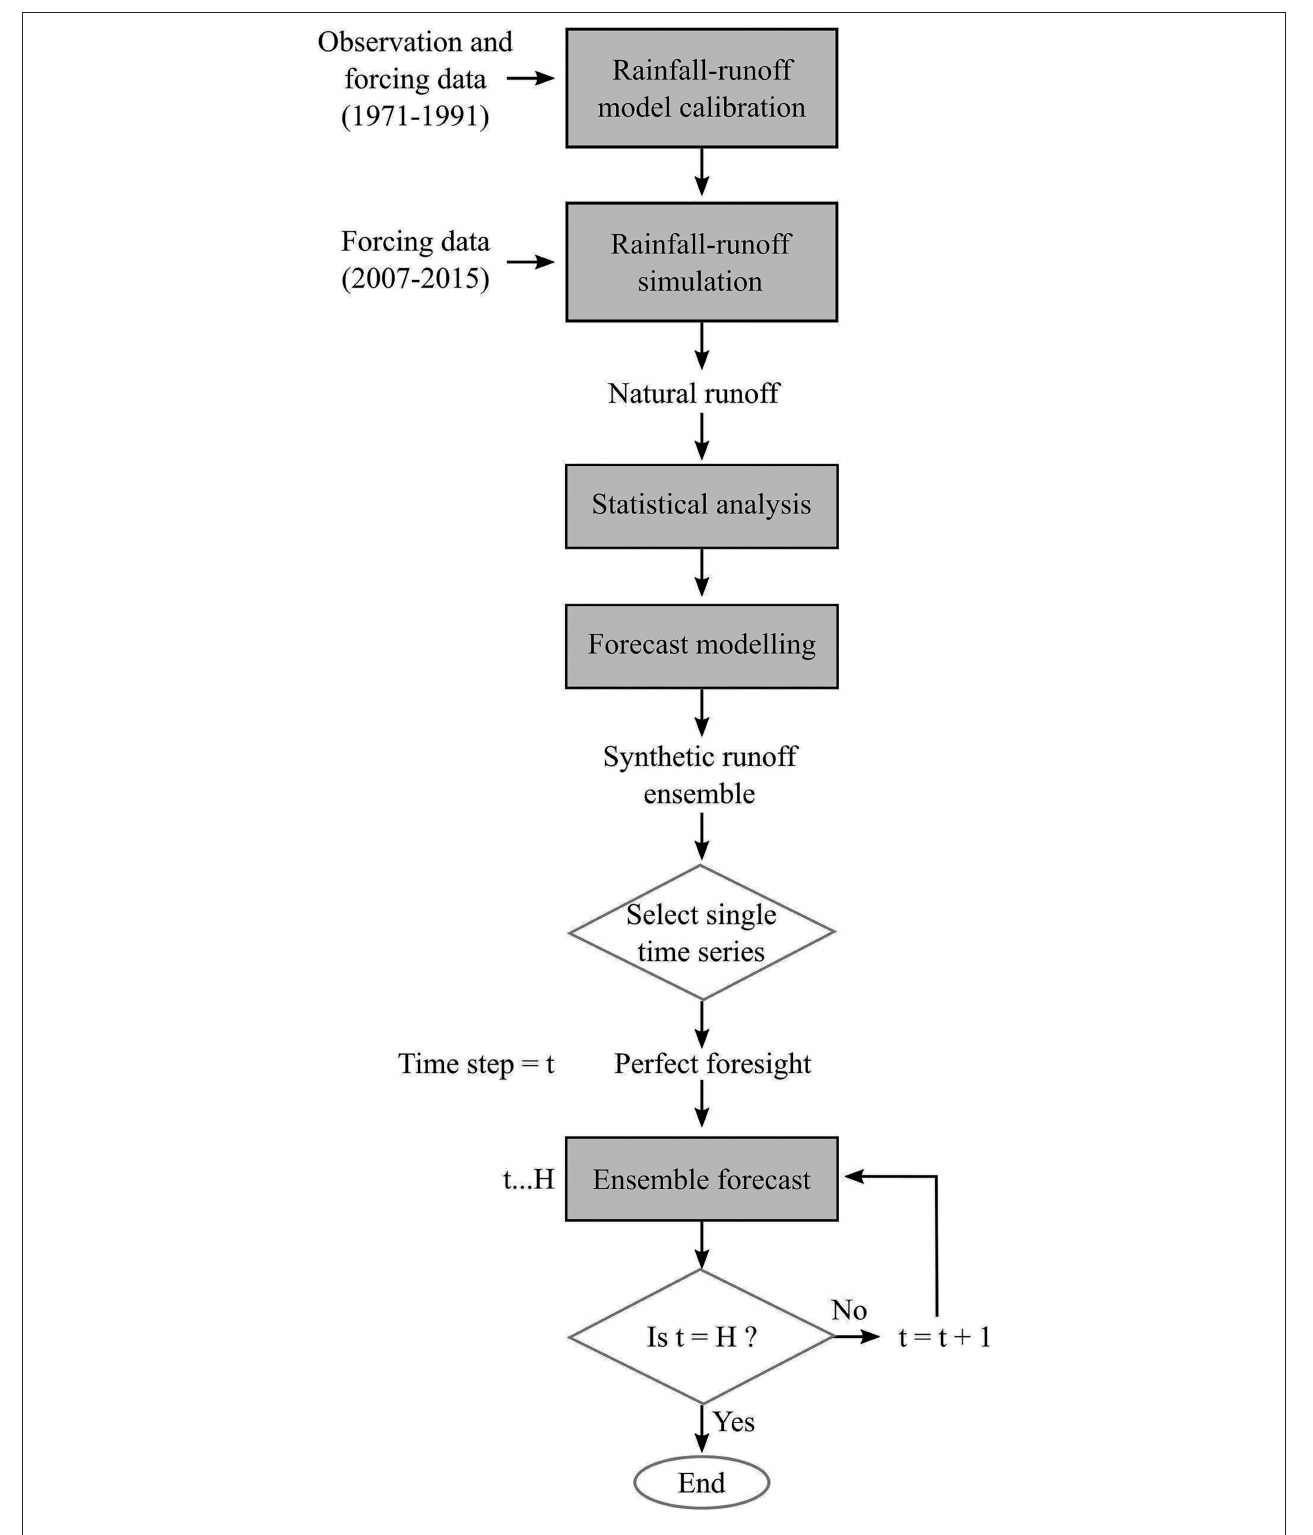
FIGURE 3 | Flowchart describing the generation of synthetic forecasting data. Processes are shown in gray rectangles, decisions in diamond shapes and input/outputs as free text.